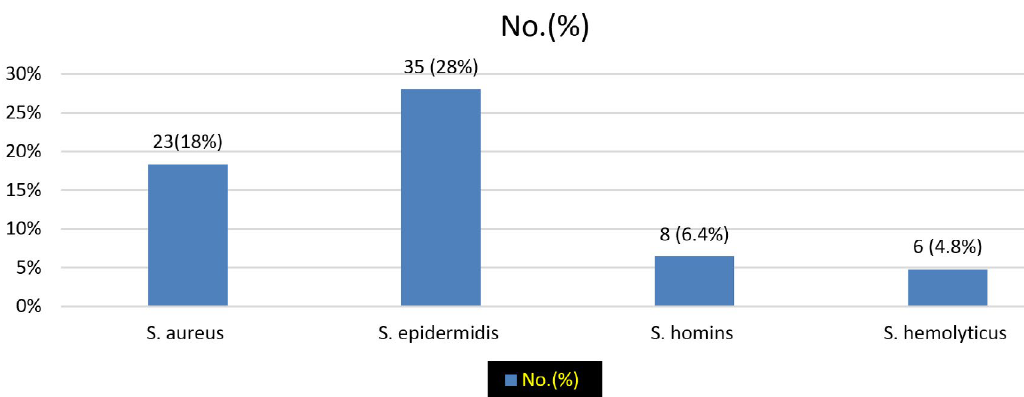
Fig. 1. Species differentiation of all the staphylococcus